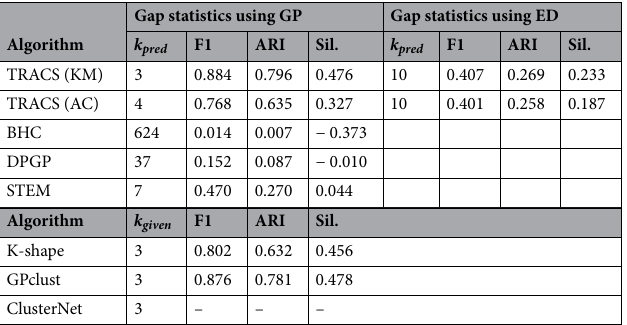
Table 2. Optimal number of clusters ( k pred ) inferred from EMT dataset ( k true =3) with a given range of [1, 20] and clustering performance evaluation with inferred k pred . Abbreviations are same as in Table